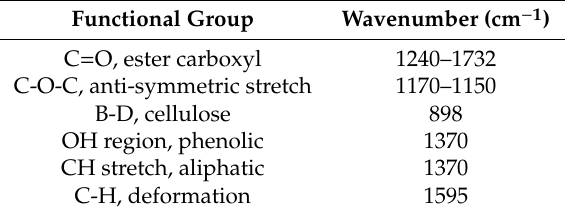
Table 2. Functional groups and their respective wavelengths on FTIR